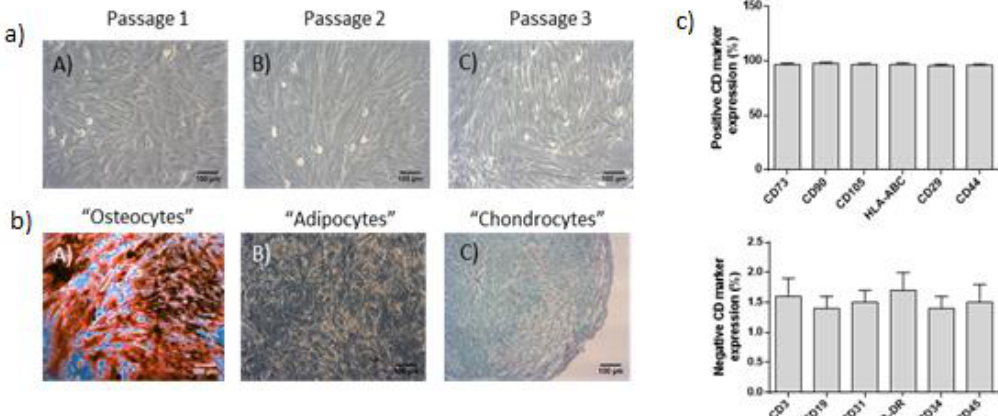
Figure 1. Expansion and quality control analysis of Adipose-Derived Stem Cells (ADSCs). ( a ) Morphology of ADSCs at passage 1 (A), 2 (B) and 3 (C). ( b ) Successful di ff erentiation of ADSCs into “osteocytes” (A), “adipocytes” (B) and “chondrocytes” (C), as it was confirmed by Alizarin Red S, Oil Red-O and Alcian Blue, respectively. ( c ) Flow cytometric analysis of ADSCs, showing the positive and negative expression of specific CD markers. Images were obtained with original magnification 10 × and scale bars 100 µ m.